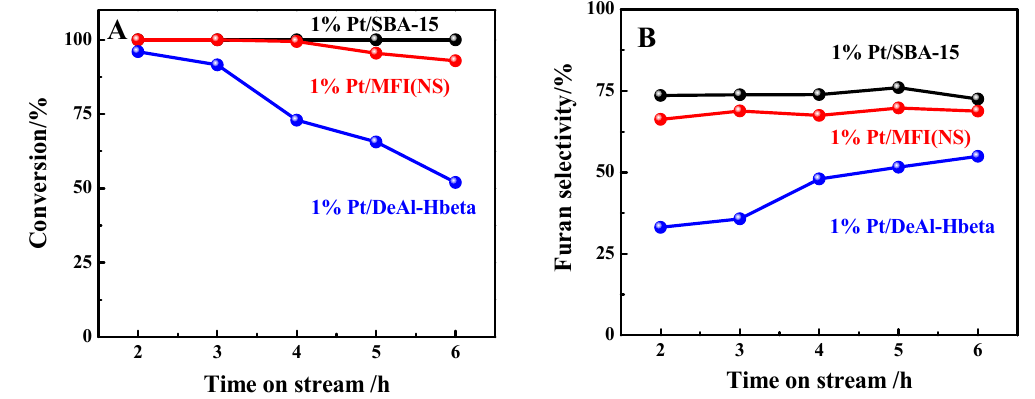
Figure 2. ( A ) Furfural conversion and ( B ) furan selectivity over Pt catalysts on different supports (reaction conditions: 573 K, weight hourly space velocity (WHSV) = 3.3 h − 1 , H 2 / furfural (mol) = 2.4).